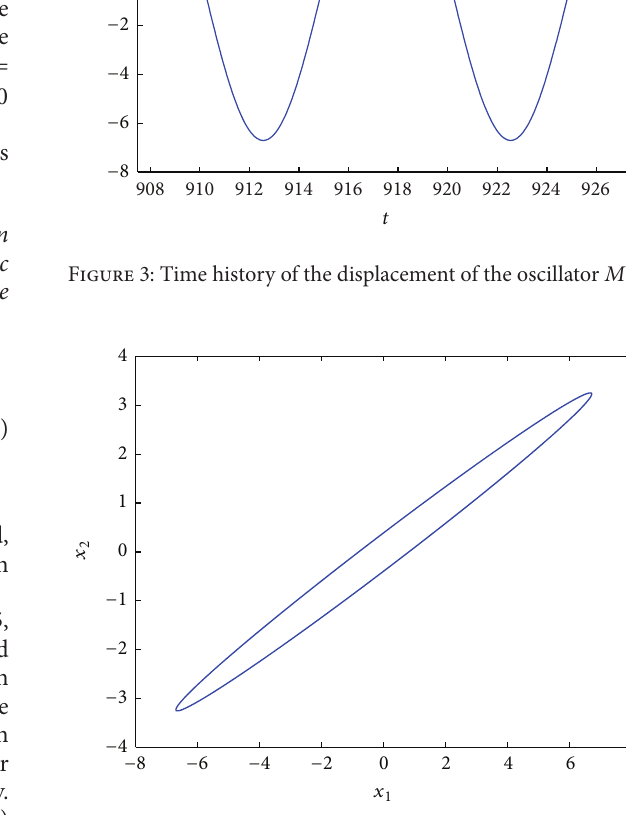
Figure 4: Phase portrait of the oscillator 𝑀 1 in (𝑥 1 ,𝑥 2 )